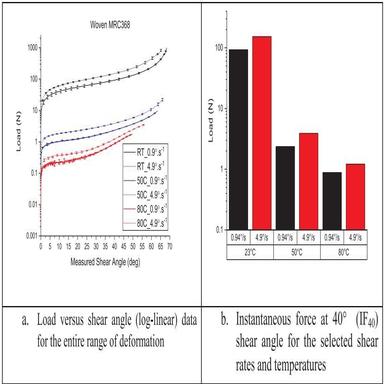
BE test results of CEP-TW2 at different temperatures and shear rates.